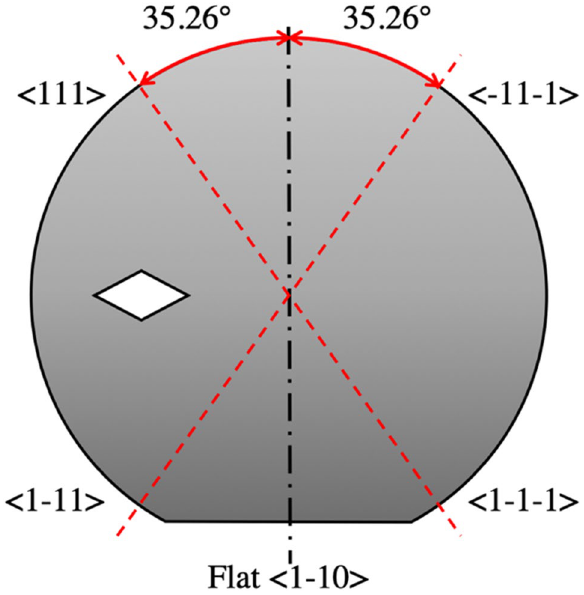
Figure 1. Wafer crystalline orientation of the <111> planes for the <110> -type silicon wafers used for the